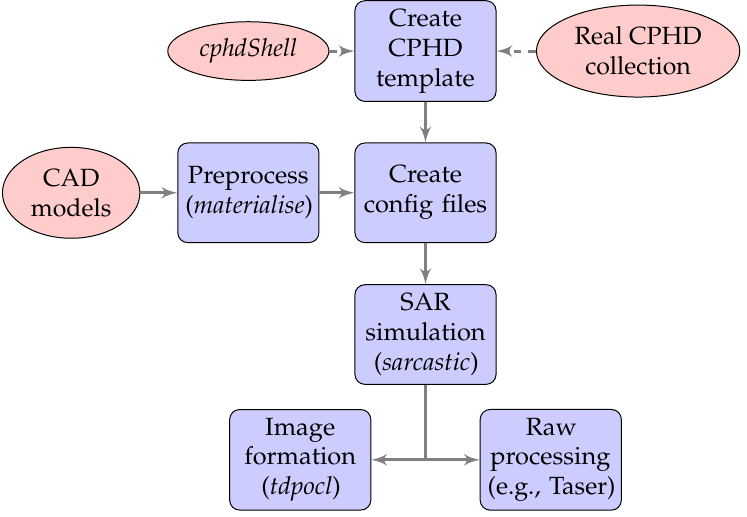
Figure 2. Typical SARCASTIC processing